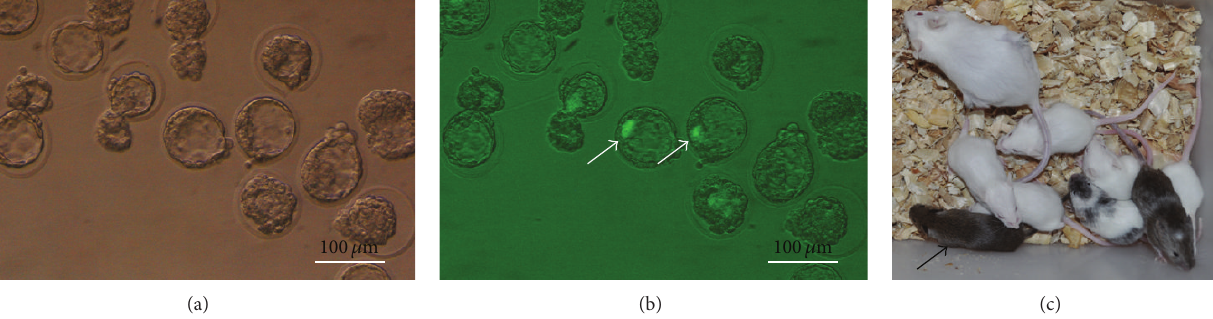
Figure 3: Generation of mouse chimeras by injection of ESCs into 8-cell embryos. Blastocysts developed from ES cell injection ((a) bright field; (b) GFP fluorescence). The white arrow shows that ESCs were aggregated into the ICM of blastocysts. Chimeric mice generated by injecting ESCs into 8-cell embryos (c). The black arrow shows the full agouti-colored chimeric